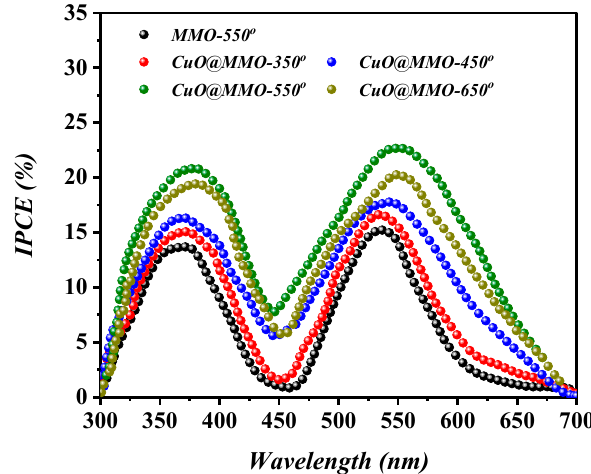
Figure 7. IPCE curves of the fabricated DSSC